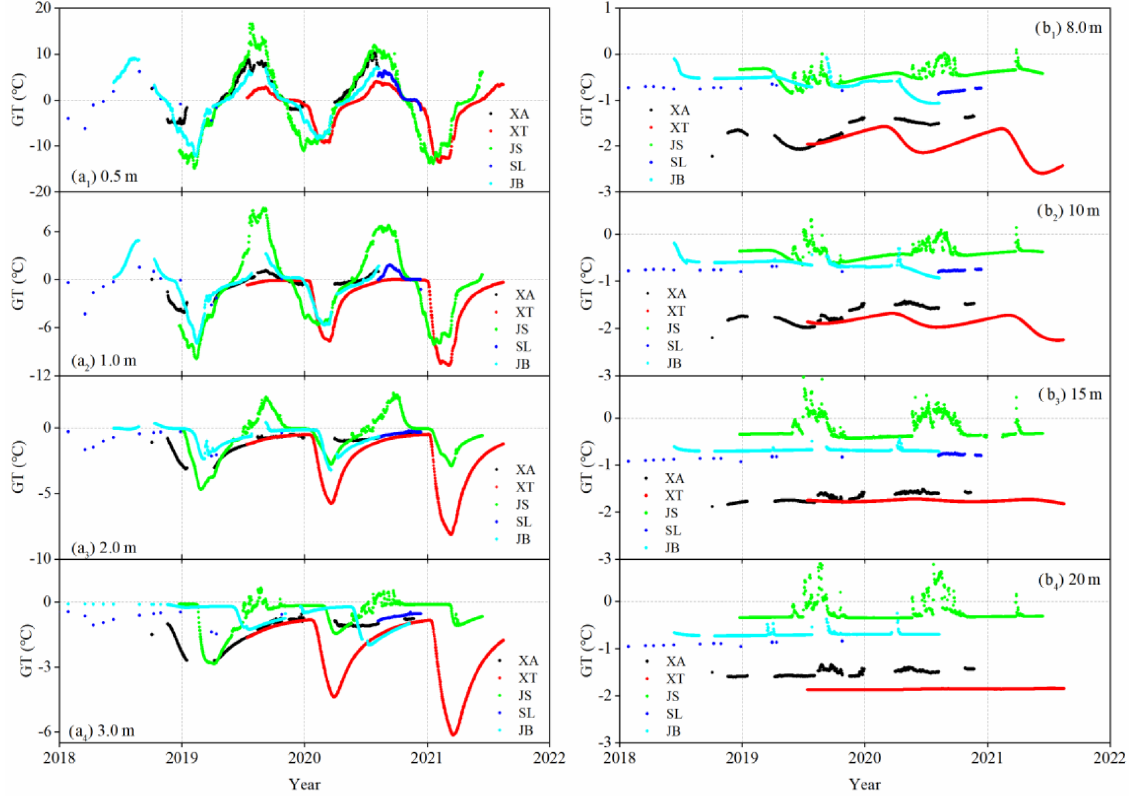
Figure 3. Variability of ground temperatures (GTs) at depths of (a) 0–3m and (b) 8–20m at the undisturbed sites along the route of China– Russia Crude Oil Pipelines (CRCOPs) in Northeast China, 2018–2021.